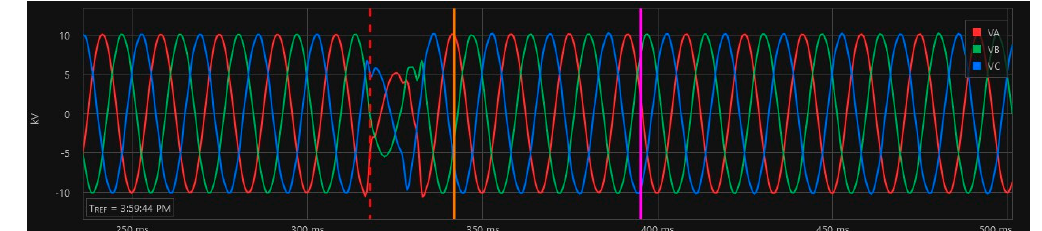
Figure 31. Phase voltages recorded by R2 under instantaneous scheme.